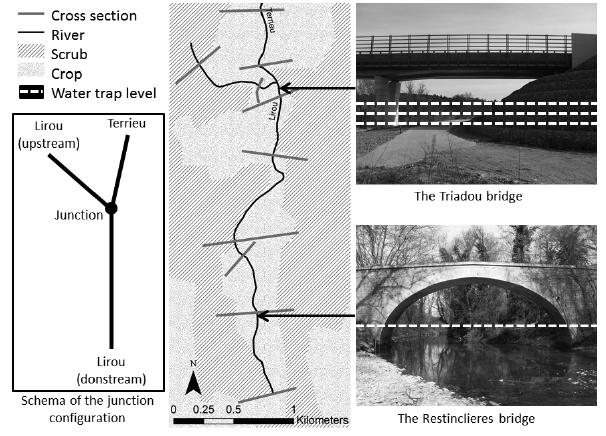
Figure 1. Sampled locations in the Lirou watershed.